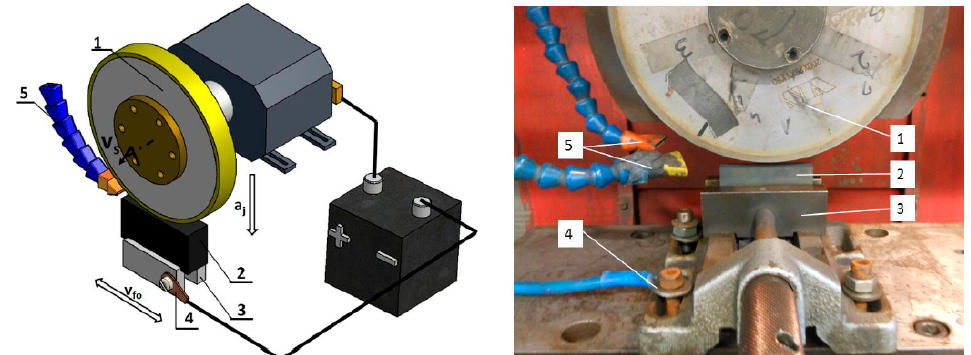
Figure 2. Diagram and view of the system for electrodischarge dressing of superhard grinding wheels with a stationary electrode: 1—grinding wheel, 2—stationary electrode, 3—machine vice jaws, 4—supplying electrical voltage from the electro-spark discharge generator, 5—dielectric supply nozzles.